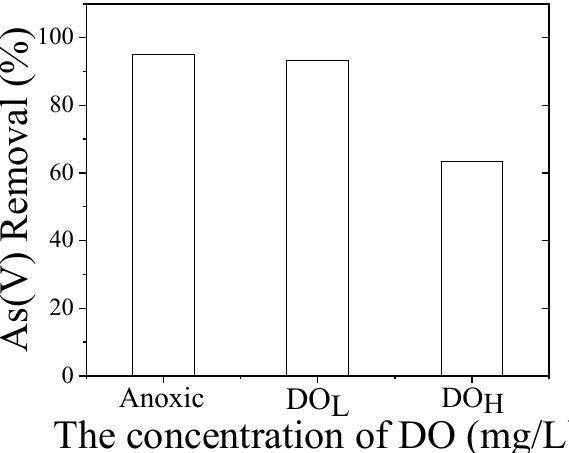
Figure 3. The effect of DO concentration on ZVI mediated the removal of arsenic at pH7, 25 ± 1 ◦ C. Initial arsenic concentration was 2.81 mg · L − 1 ; anoxic: DO < 0.5 mg · L − 1 , DO L = 7.0 mg · L − 1 , DO H = 14 mg · L − 1